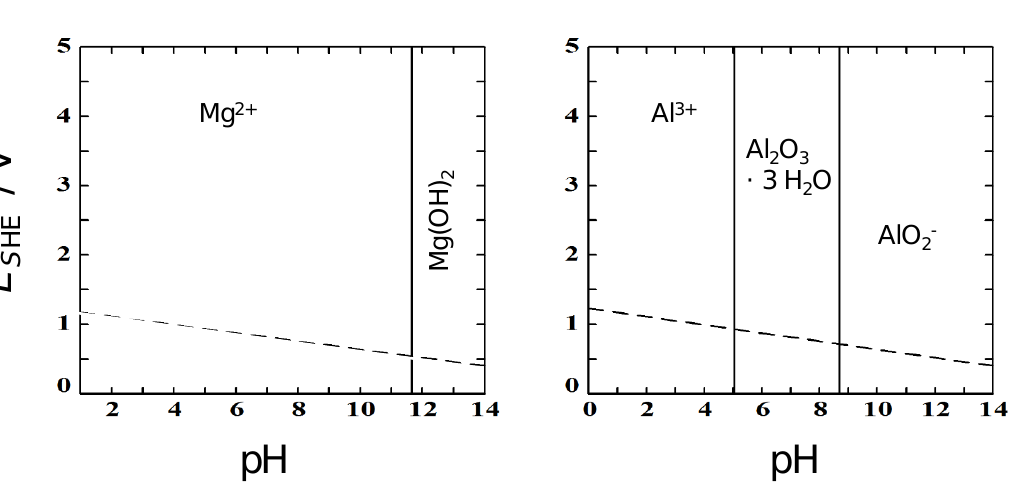
Figure 10. Pourbaix diagrams of magnesium (left) and aluminium (right) according to [32] drawn with the MEDUSA software [33], dashed lines mark the hydrolysis of water, potential related to the standard hydrogen electrode